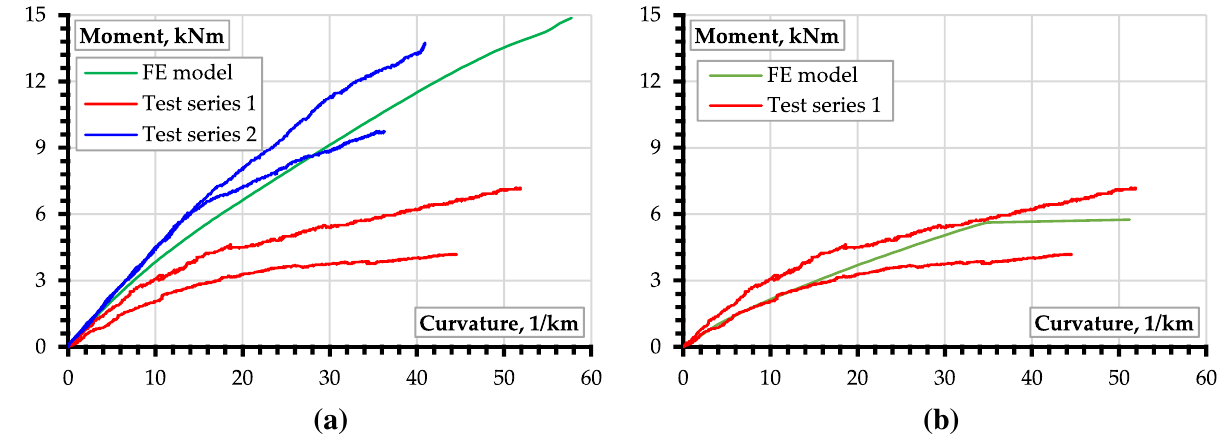
Figure 6. The experimental moment–curvature relationships of the hybrid beams compared with numerical predictions: ( a ) the reference model with the perfect bond between the composite components; ( b ) the model assumed a weak contact between the GFRP profile and concrete support blocks.